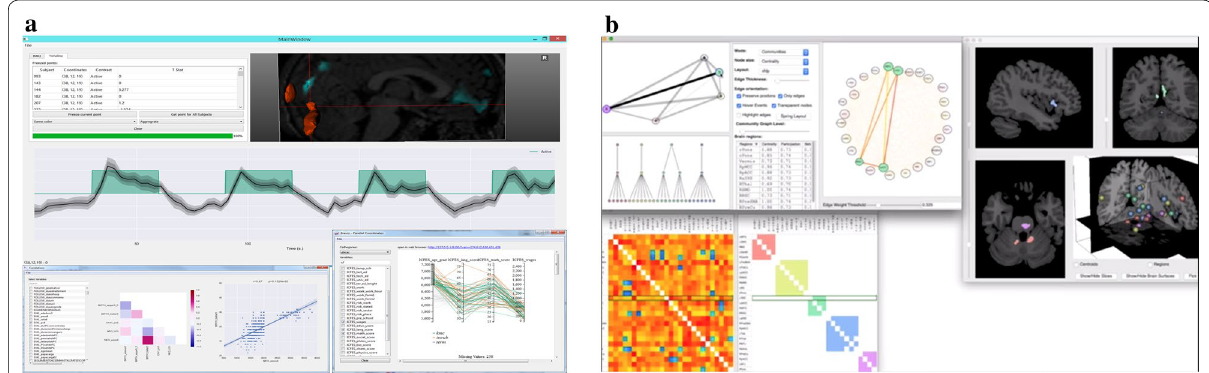
Fig. 11 Examples of multimodality and data source windowed approaches: a three windows created in BraViz [90] showing an fMRI timeline above two windows of population demographic statistics; b Brain Modulyzer [92] displaying derived statistics alongside fMRI connectivity data